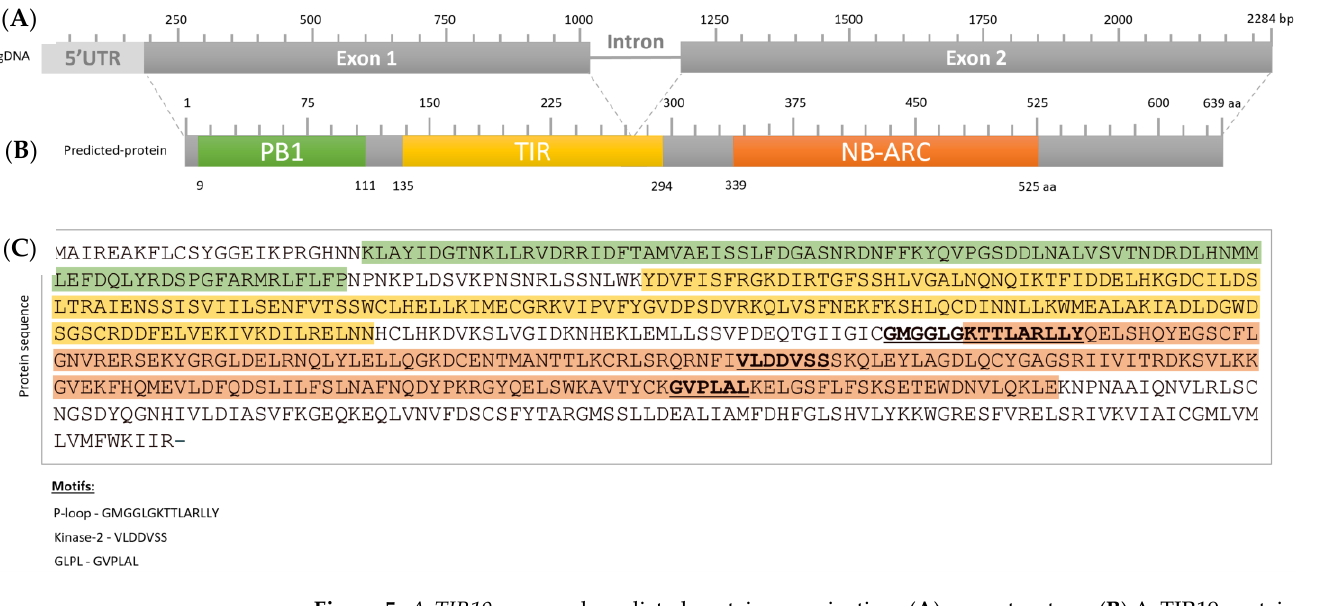
Figure 5. AsTIR19 gene and predicted protein organization. ( A ) gene structure; ( B ) AsTIR19 protein domains; ( C ) AsTIR19 amino acid sequence.